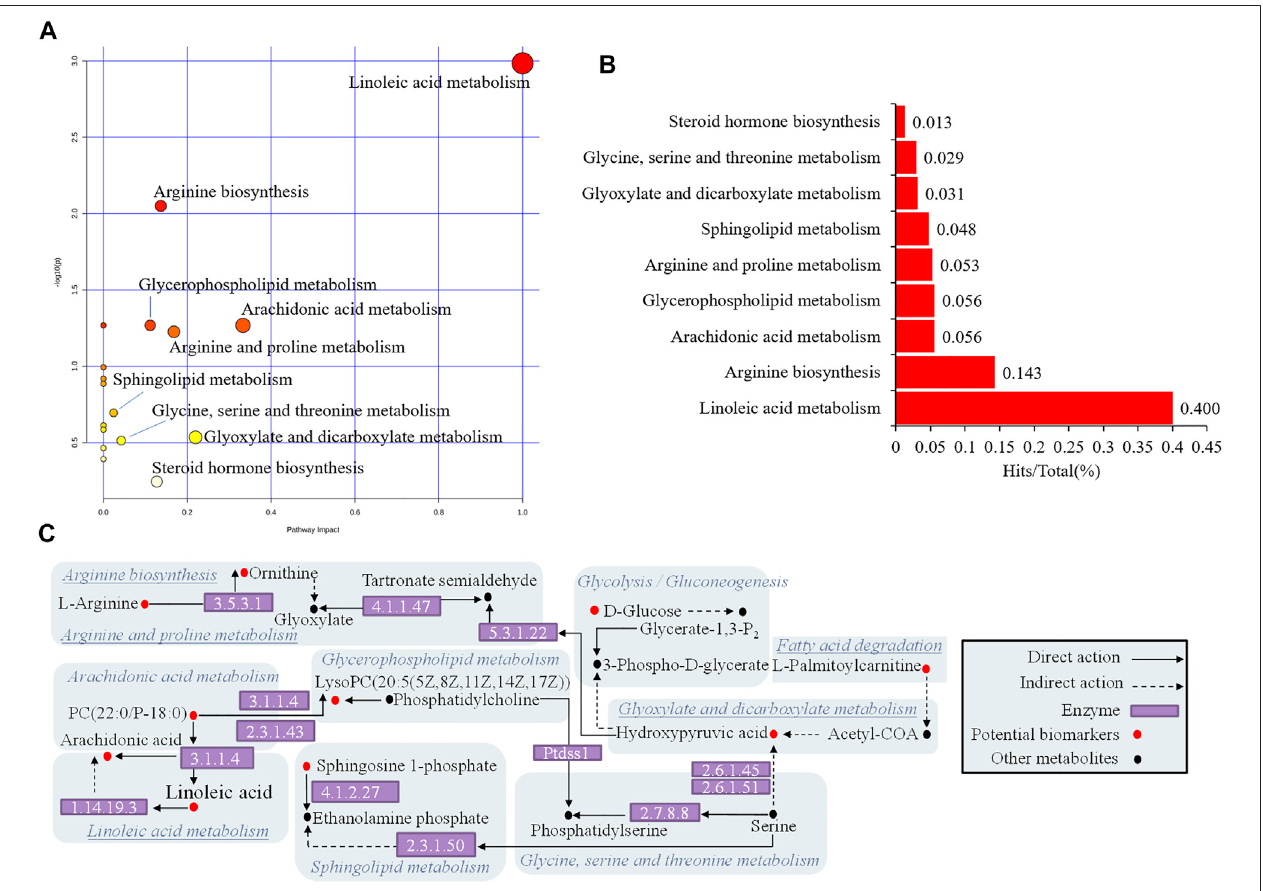
FIGURE 6 | Enrichment analysis of metabolic pathway of potential biomarkers. (A) Pathway impact enrichment (B) The proportion of biomarkers in the overall pathway (C) Association network of biomarker metabolic pathways.